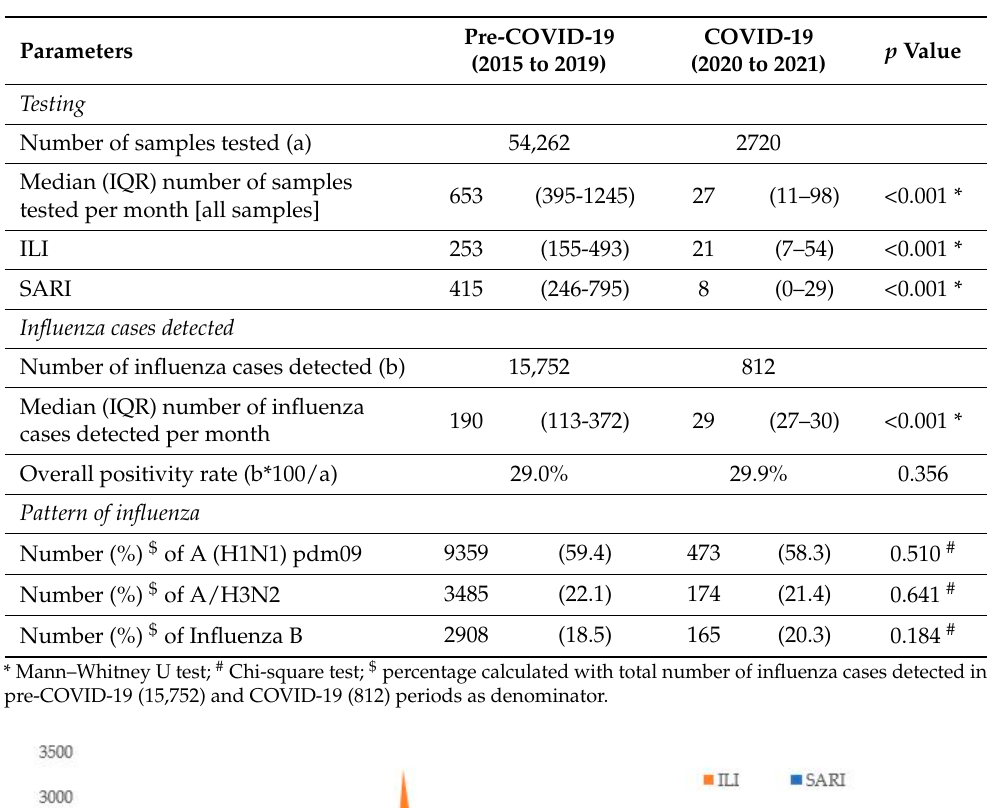
Table 1. Number of samples tested for influenza and pattern of influenza cases detected at MIV, Karnataka during the pre-COVID-19 (2015 to 2019) and COVID-19 periods (2020 to 2021).